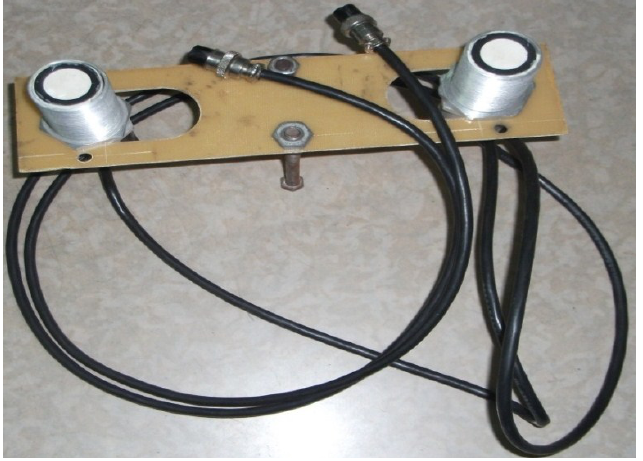
Figure 15. The two parallel ultrasonic sensors fixed on one